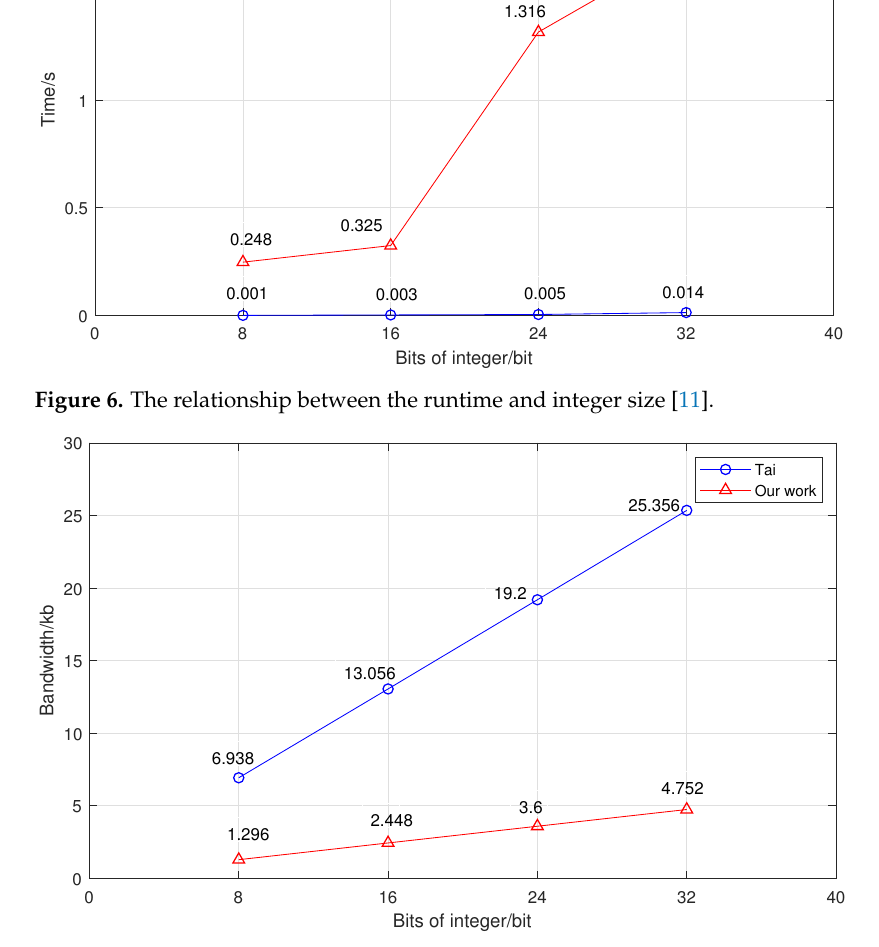
Figure 7. The relationship between the bandwidth and integer size